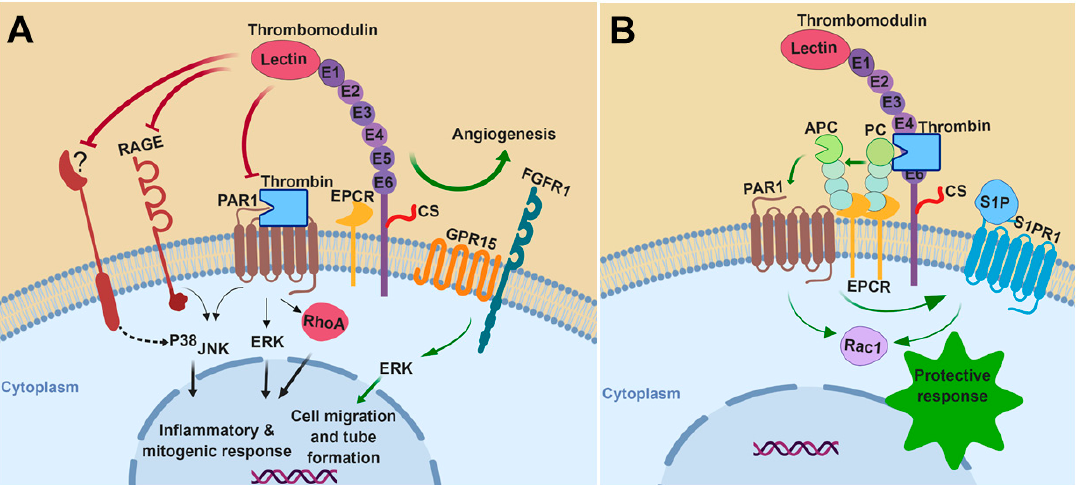
Figure 1. A hypothetical model for the role of thrombomodulin (TM) in mitogen-activated protein kinases (MAPKs) signaling: Thrombomodulin regulates the activation of MAPKs under various pathophysiological conditions. ( A ) Under inflammatory and mitogenic conditions, TM attenuates MAPK pathways by inhibiting the signaling functions of protease-activated receptor 1 (PAR1), receptor for advanced glycation end products (RAGE), and other unknown receptor(s). During angiogenesis, it promotes extracellular signal-regulated kinase (ERK)-mediated vessel growth through activation of protein C (PC) to activated protein C (APC) and crosstalk with other receptors such as G-protein coupled receptor 15 (GPR15) and fibroblast growth factor receptor 1 (FGFR1). ( B ) TM functions as a cofactor for thrombin to mediate the activation of PC to APC, thereby initiating anti-inflammatory and cytoprotective signaling responses through APC-mediated activation of PAR1, inhibition of RhoA and promoting a protective signaling pathway through Rac1. APC trans-activates S1PR1 receptor to enhance the barrier permeability function of endothelial cells. CS, chondroitin sulfate; PC, protein C; APC, activated protein C; EPCR, endothelial protein C receptor; RAGE, receptor for advanced glycation end-products; PAR1, protease-activated receptor 1; GPR15, G-protein coupled receptor 15; FGFR1, fibroblast growth factor receptor 1; S1PR1, sphingosine 1-phosphate receptor 1;